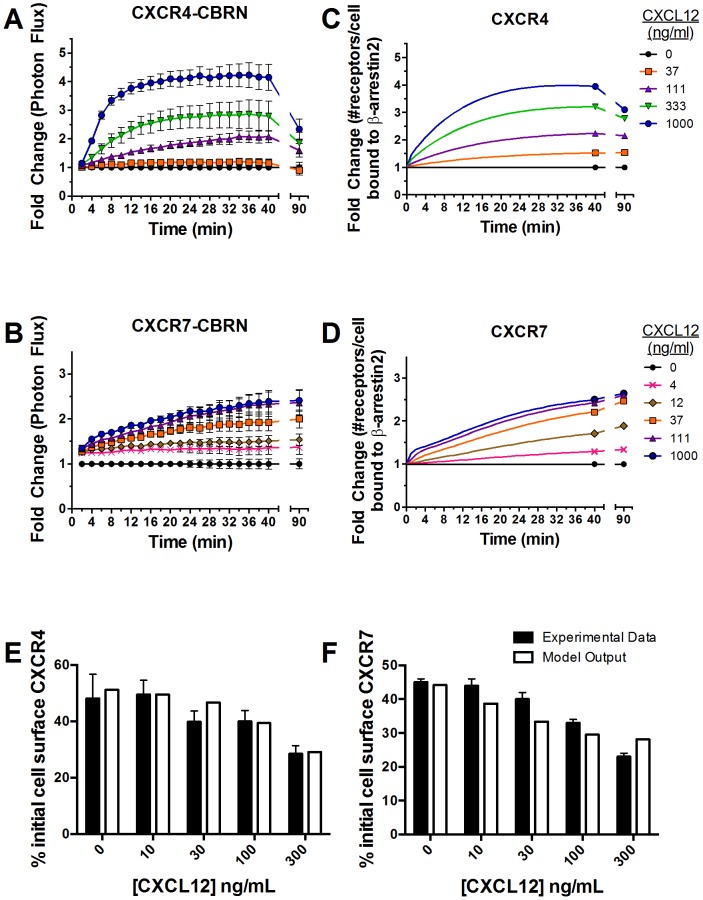
Kinetics of β-arrestin 2 recruitment to CXCR4 or CXCR7.(A and B) MDA-MB-231 breast cancer cells expressing CXCR4-CBRN/β-arrestin 2-CBC (A) or CXCR7-CBRN/β-arrestin 2-CBC (B) were treated with increasing concentrations of CXCL12-α (ng/mL) as denoted in the legend. Data were collected as photon flux units. Photon flux values for each time point then were normalized to values obtained for control cells not incubated with CXCL12 at each time point through 40 min and at 90 min. Data are expressed as mean values ± SEM for fold change relative to control (n = 4 per point). (C and D) Experimental data were used to tune parameters for a computational model describing numbers of receptors per cell bound to β-arrestin 2. Model outputs for CXCR4 (C) and CXCR7 (D) were plotted as fold change relative to cells not treated with CXCL12. (E, F) Internalization of cell surface CXCR4 (E) or CXCR7 (F) following 40 min or 30 min, respectively, of incubation with CXCL12 was measured by flow cytometry. Values for 0 ng/ml CXCL12 describe internalization of CXCR4 or CXCR7 in the absence of ligand. Experimental data for CXCR7 were replotted based on previously published results [12]. Model fits also are shown.